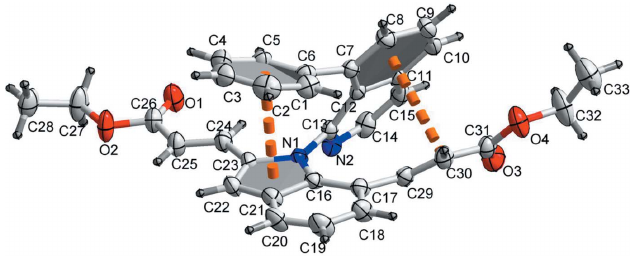
Figure 1 The molecular structure of the title compound with displacement ellipsoids drawn at the 50% probability level showing the intramolecular (cid:2) – (cid:2) and C—H (cid:3)(cid:3)(cid:3) (cid:2) interactions as dashed